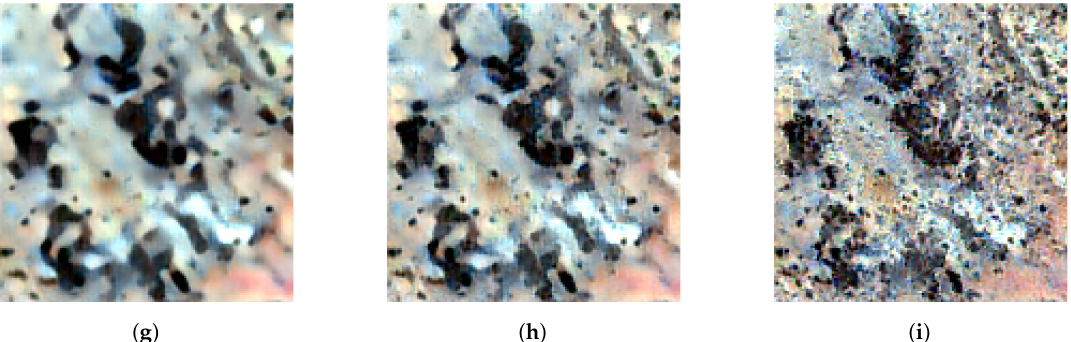
Figure 9. Results of a region of Teide-2017 from W-S Set1. ( a ) HR, ( b ) LR with NN interpolation, ( c ) LR with bicubic interpolation, ( d ) SR with α = 0, ( e ) SR with α = 0.1, ( f ) SR with α = 0.2, ( g ) SR with α = 0.5, ( h ) SR with α = 0.7, ( i ) SR with α = 1. Image size: 140 × 140 pixels.